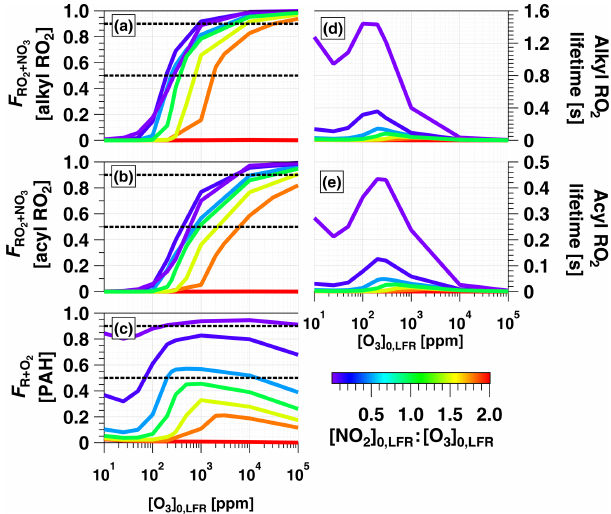
Figure 8. F RO for (a) alkyl and (b) acyl RO 2 , and (c) F R + O 2 + NO 3 over the same OFR-iN 2 O 5 operating conditions and model inputs used to generate Fig. 7, with the corresponding lifetimes for (d) alkyl and (e) acyl RO 2